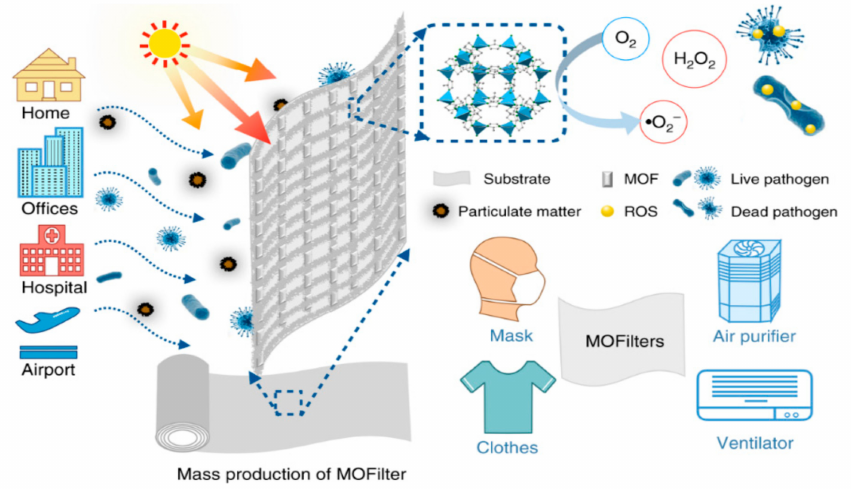
Figure 12. Schematic illustration of metal-organic framework (MOF)-based filter (MOFilter) for integrated air cleaning. Adapted and reprinted with permission from [232], Copyright (2019) Springer